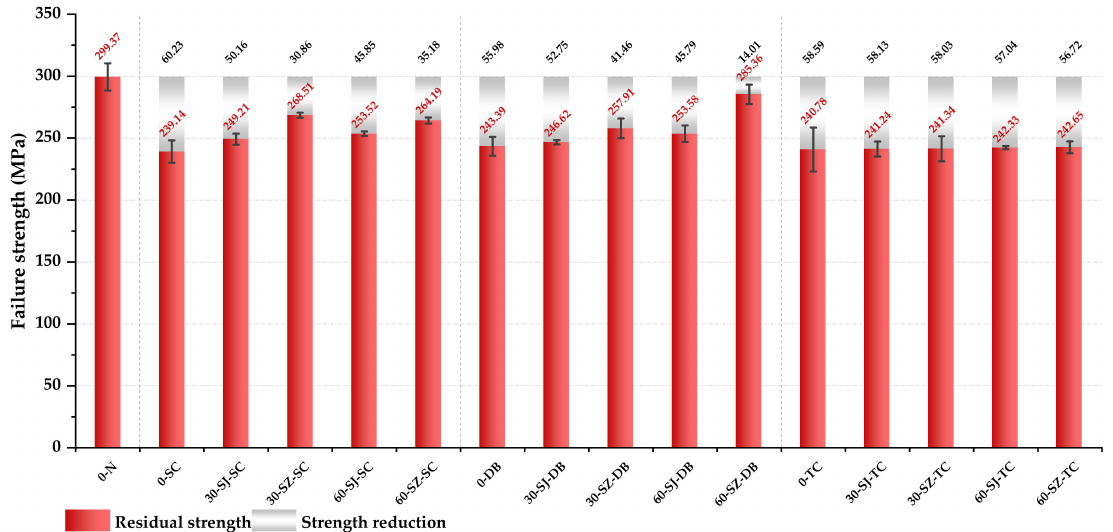
Figure 12. Comparison of residual compressive properties of different types of